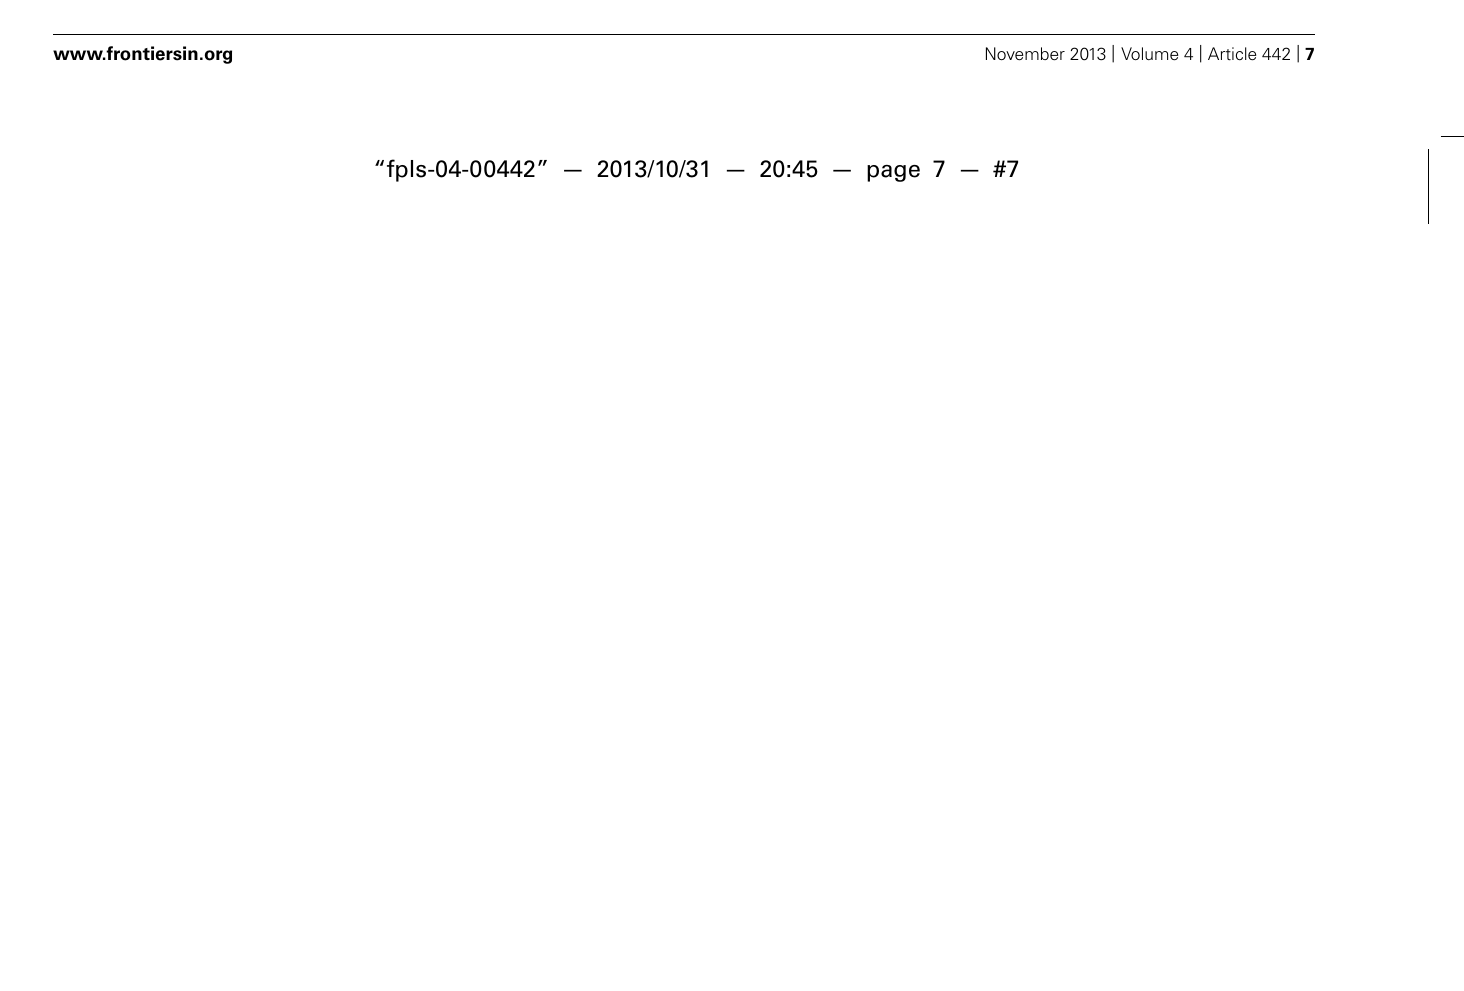
FIGURE 4 | Seasonal root growth of fully and deficit irrigated maize and sunflower in two soil depths. Root growth across the season at two soil depths for Z. mays (A,C) and H. annuus (B,D) is from the same study shown